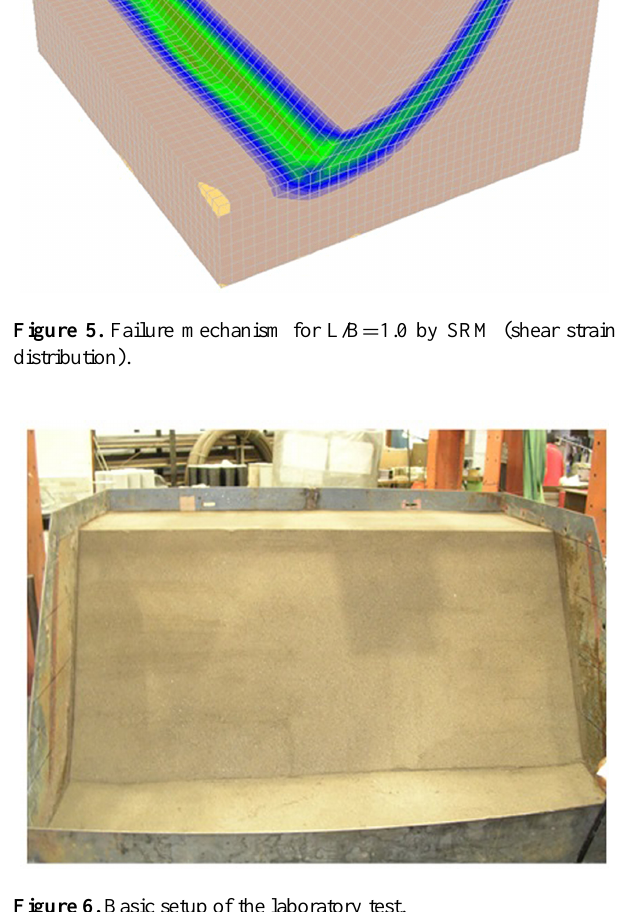
Figure 6. Basic setup of the laboratory